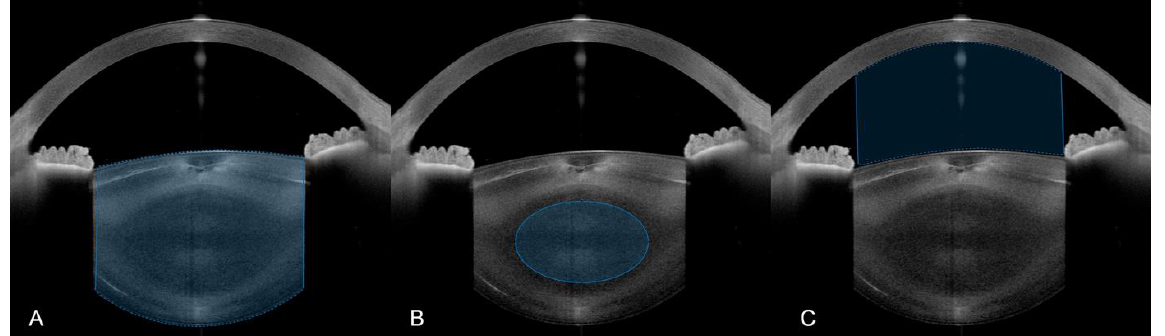
Figure 1. Automatic segmentation of ( A ) the entire lens, ( B ) the nucleus and ( C ) the anterior chamber in SS-OCT images performed by a custom MATLAB script.